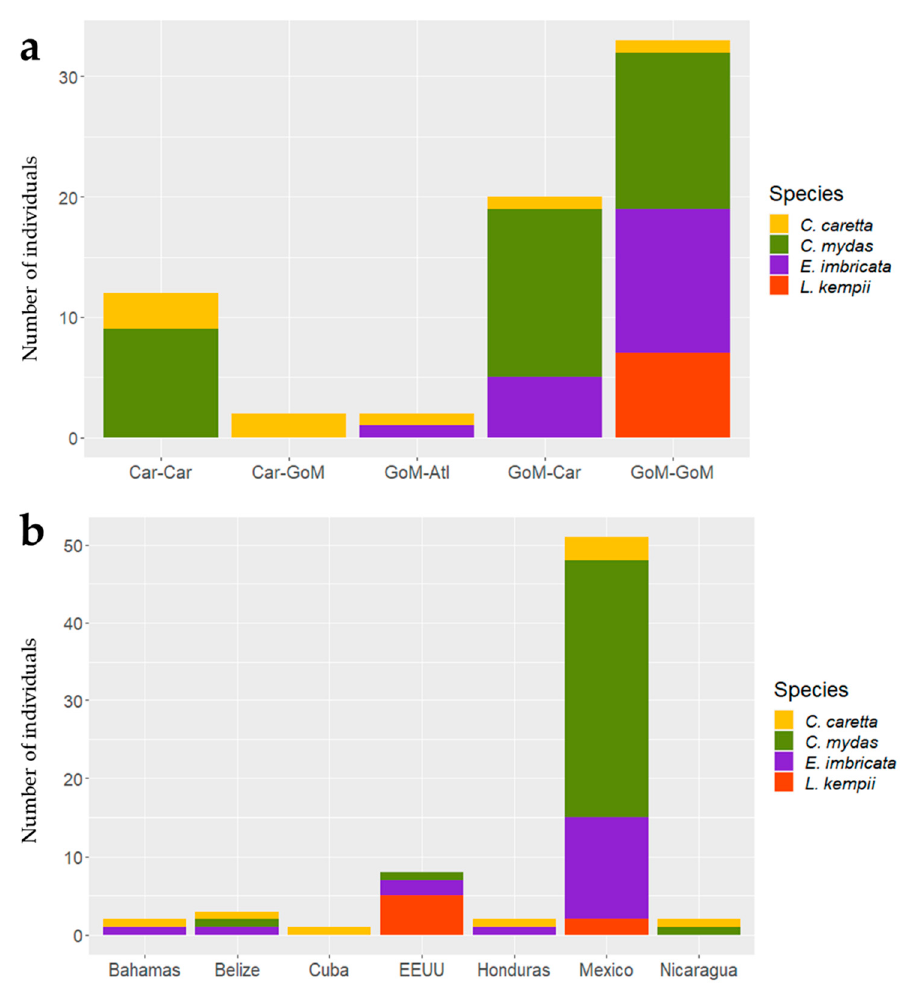
Figure 5. Spatial connectivity of the ocean basins in the West Atlantic ( a ) depicted by the individuals of the four sea turtle species moving from the Mexican littoral, and the connectivity between national water ( b ) in the West Atlantic. (Car: Caribbean, GoM: Gulf of Mexico, Atl: Atlantic). In terms of the territories of the countries, at least one individual of the four species moved out of the Mexican marine territory, and all species connected the Mexican and